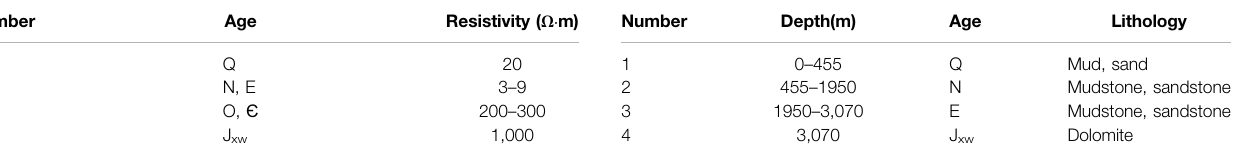
TABLE 1 | Resistivity of regional formation. TABLE 2 | Geologic framework of